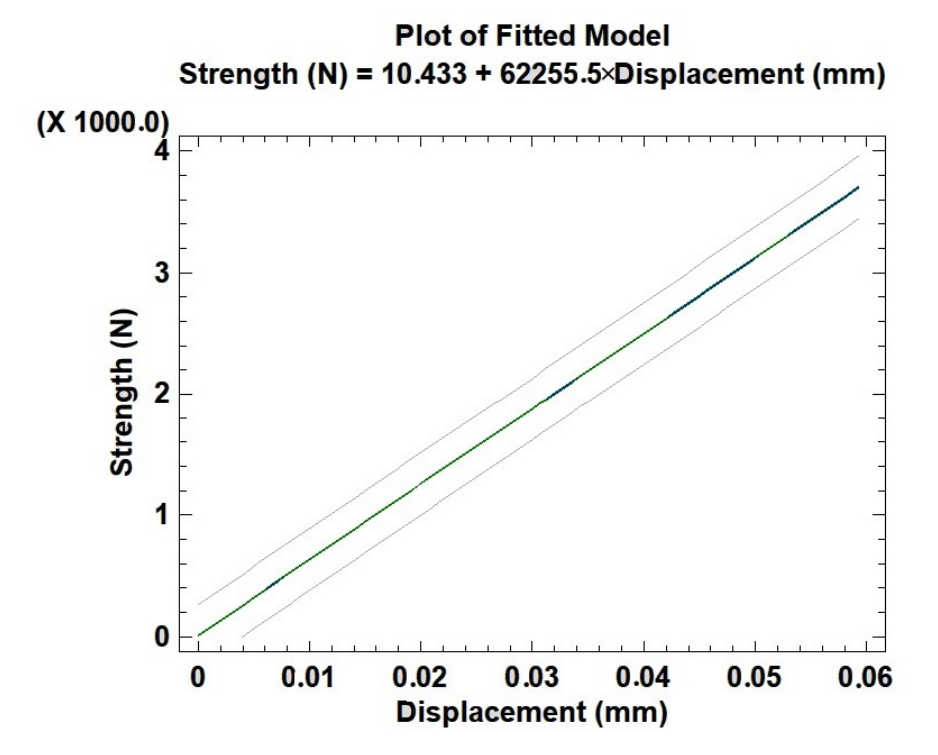
Figure 14. Graph of the adjusted model Test 3. Composite material 60% fly ash (D: 20 mm/E: 70 mm). For all samples, Young’s modulus is obtained from compression curves [37] with linear regression using Statgraphics